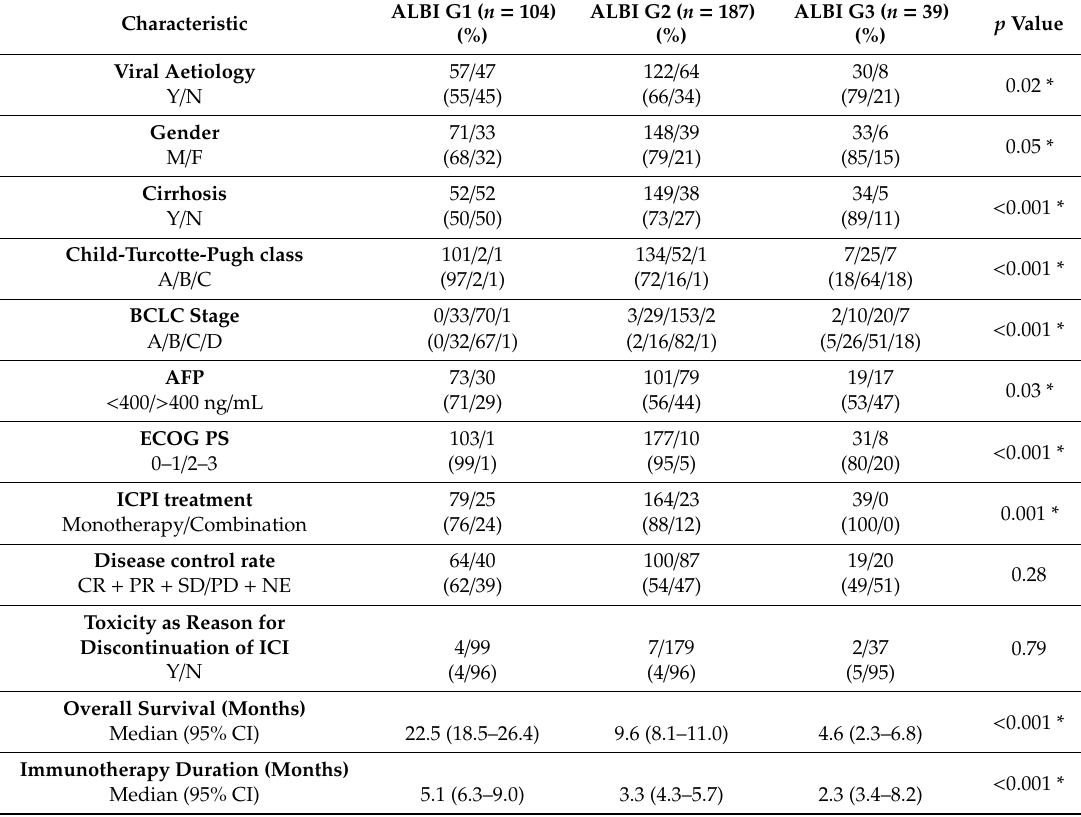
Table 2. The relationship between baseline albumin-bilirubin (ALBI) grade and salient clinico-pathologic variables.